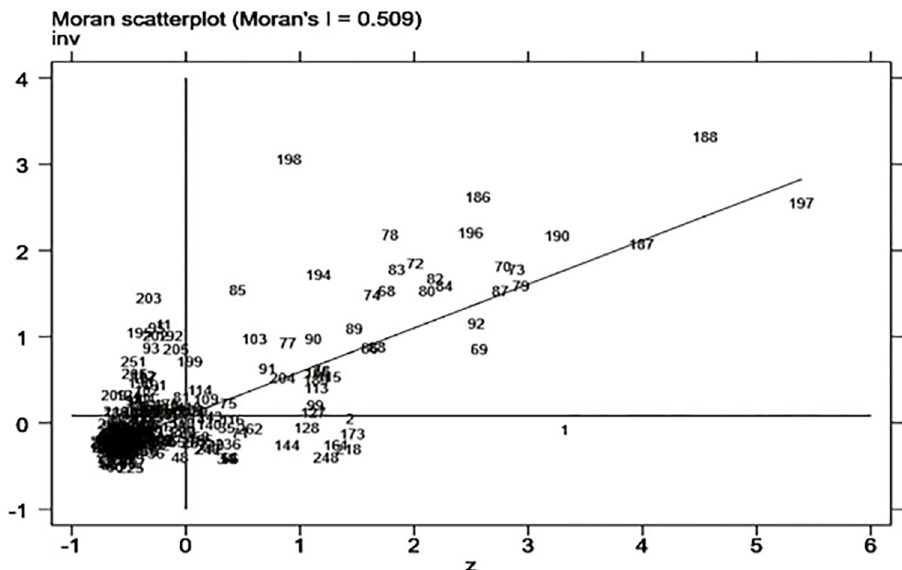
Fig 1. Moran scatterplot of Chinese cities’ innovation level in 2017.